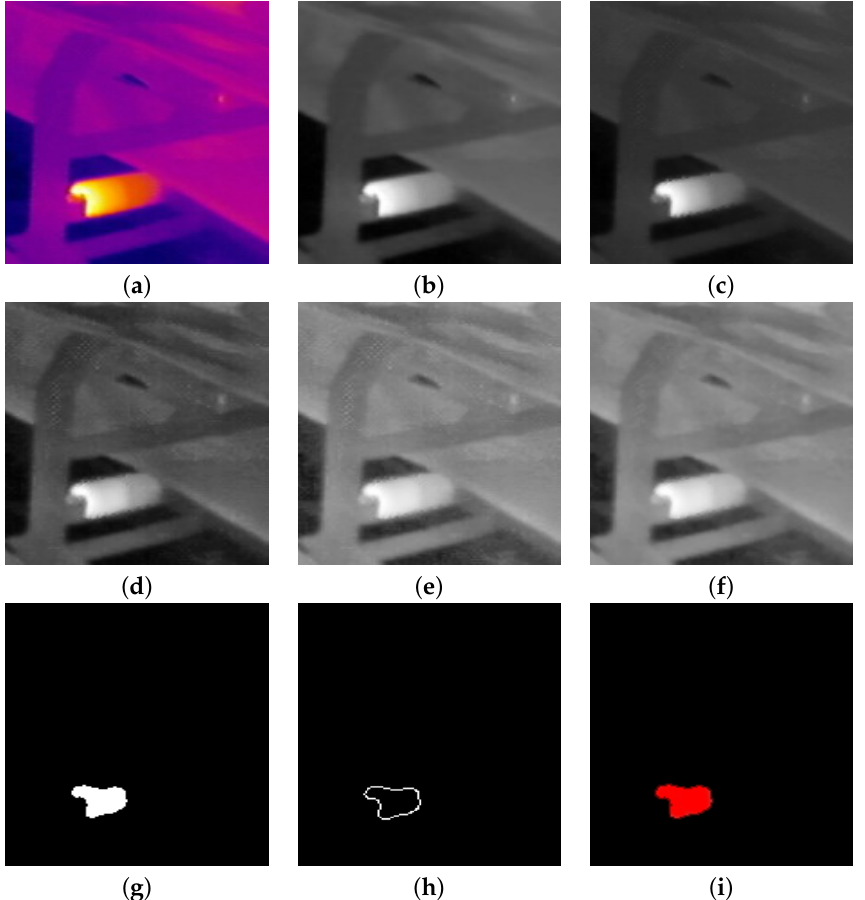
Figure 6. Intermediate and final results of presented overheated idlers module detection approach. ( a ) Original IR image, ( b ) Grayscaled, ( c ) Normalization, ( d ) CLAHE, ( e ) Gamma correction, ( f ) Me- dian filter, ( g ) Thresholding, ( h ) Canny edge detection, ( i ) Blob detection